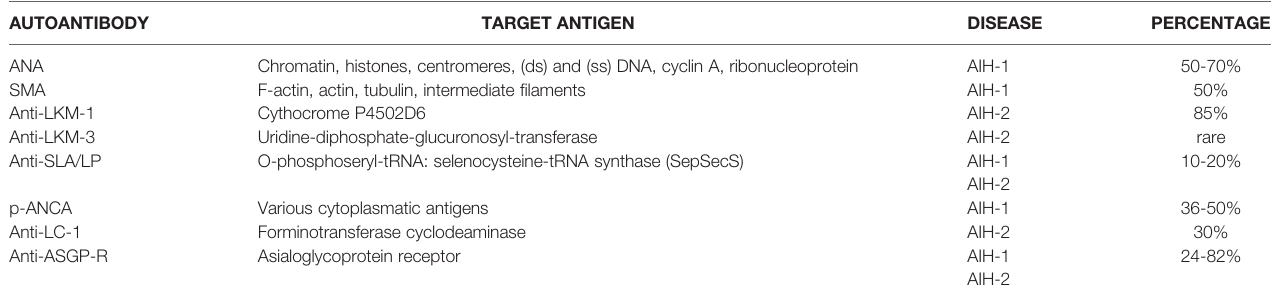
AIH, autoimmune hepatitis; ANA, antinuclear antibody; SMA, anti-smooth muscle antibody; Anti- LKM-1, anti-liver/kidney-microsomal-antibody-type-1; Anti-LKM-3, anti-liver/kidney- microsomal-antibody-type-3; Anti-SLA/LP, anti-soluble liver antigen/liver pancreas antigen; p-ANCA, perinuclear anti-neutrophil cytoplasmic antibody; anti-LC-1, anti-liver cytosolic antigen type 1; Anti-ASGP-R, anti-asialoglycoprotein receptor; ds, double strands; ss, single